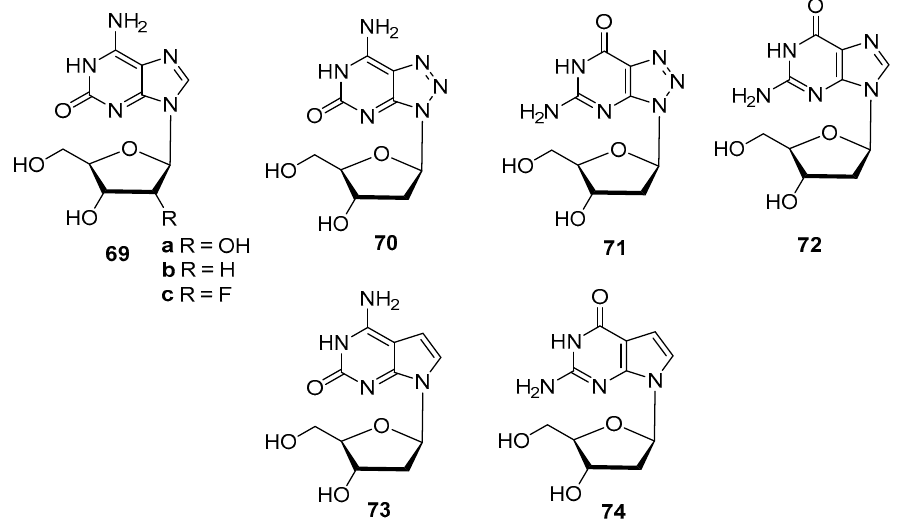
Figure 45. Nucleoside derivatives based on guanosine analogs [93].